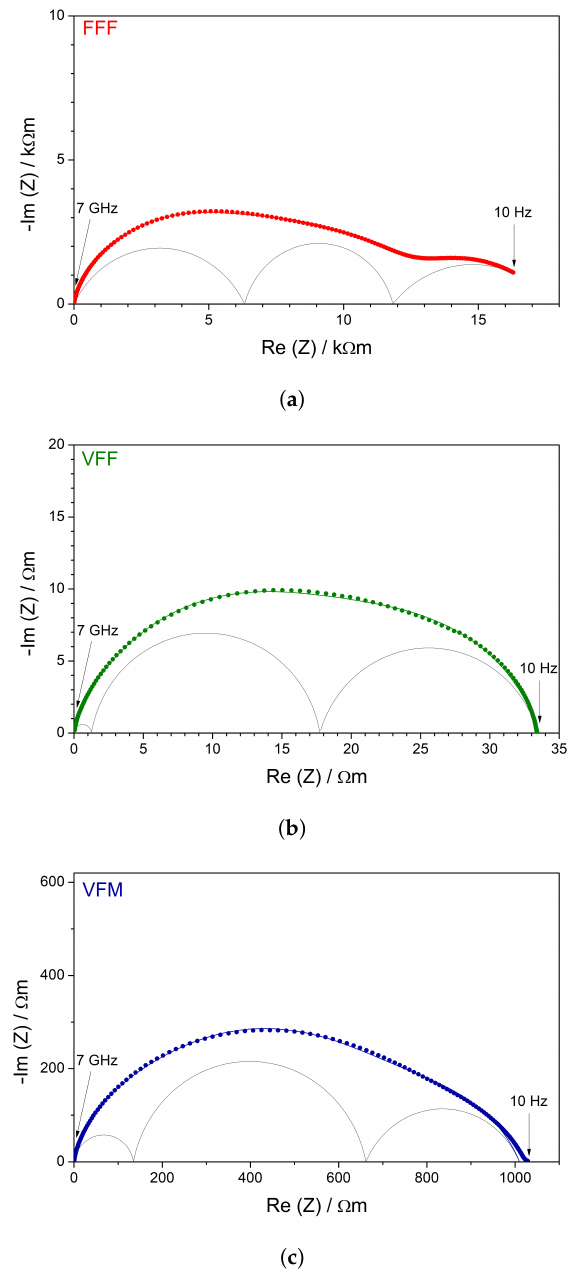
Figure 3. Impedance figures (Nyquist plots) of nanocrystalline materials measured at room tempera- ture: FFF ( a ), VFF ( b ), and VFM ( c ). Total fits (colorful solid line) and partial fits of the (RP) elements (gray lines) are included in the